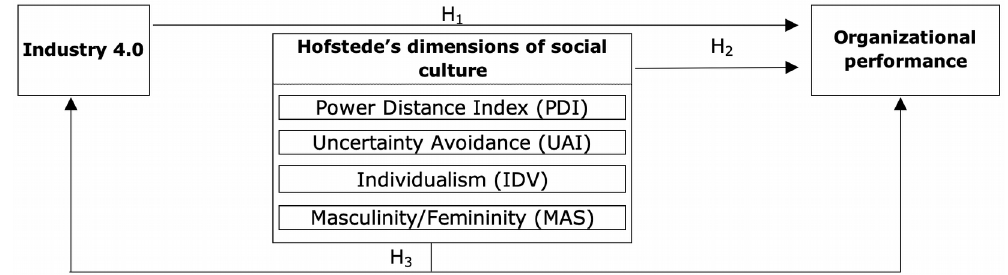
Figure 1. Proposed Research Model. Model between Industry 4.0, social culture, and organizational